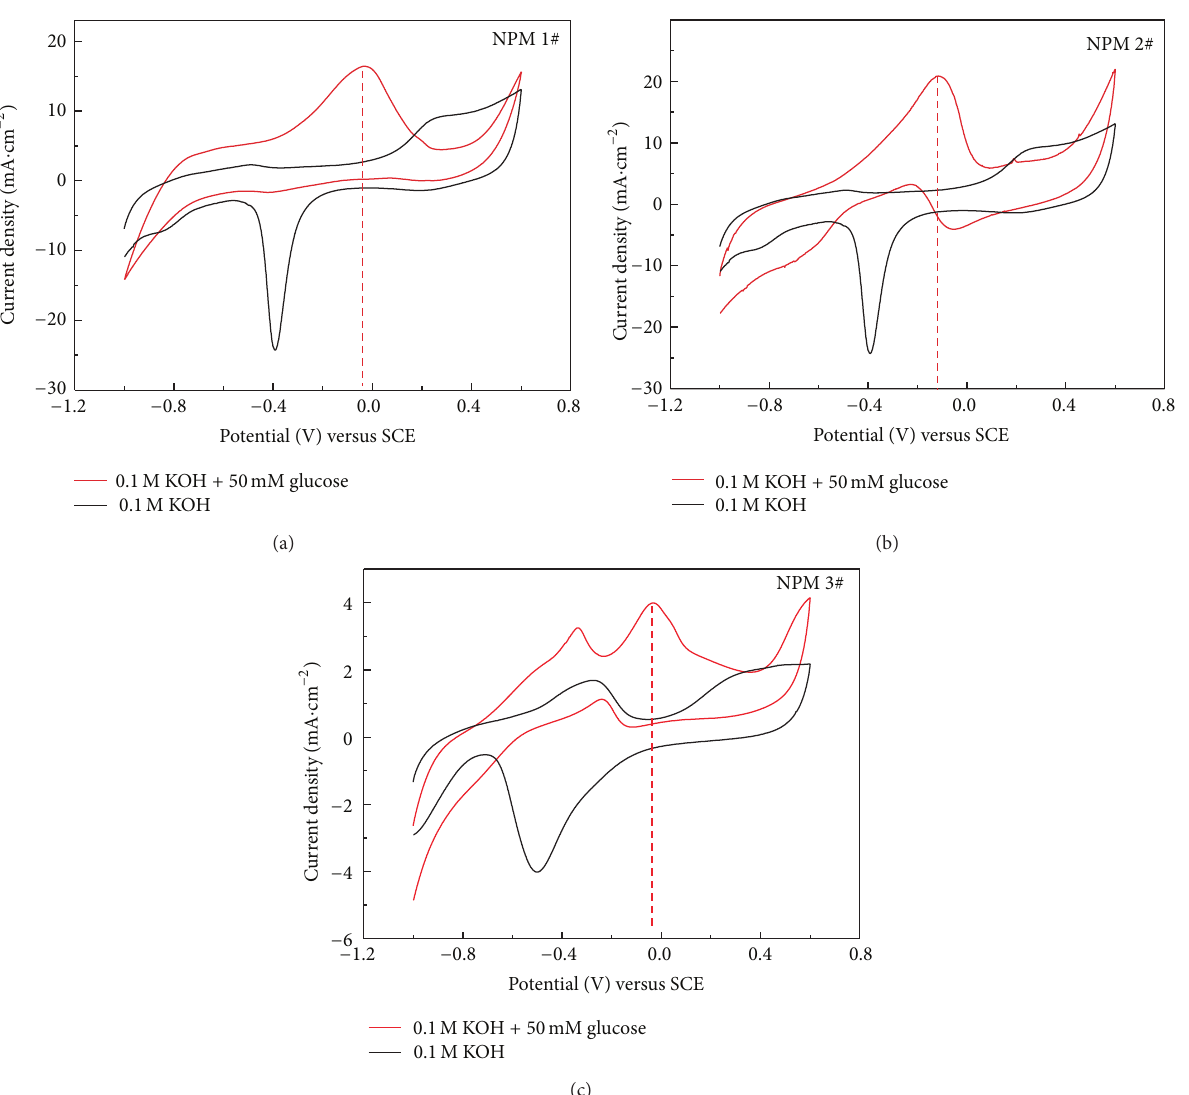
Figure 4: CV curves of the NPMs in 0.1M KOH solution with and without 50mM glucose, scan rate: 0.05 V/s.